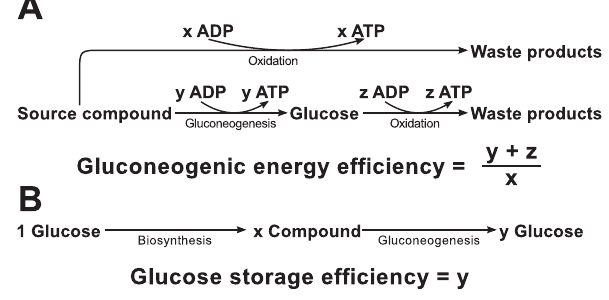
Figure 6. Pathway overview and storage efficiencies of selected compounds. A Overview of ATP, NADPH and NADH consumption for gluconeogenesis from acetyl-CoA for all detected pathways (see Text S1). Furthermore, Gibbs free energy changes of all pathways for gluconeogenesis from acetyl-CoA and palmitate are given. B Gluconeogenic energy efficiencies and glucose storage efficiencies for selected compounds. Amino acids marked with an asterisk cannot be synthesized from glucose in humans. ‘‘Palmitic acid (eff.)’’ refers to the most energy efficient pathway for gluconeogenesis from fatty acids (pathway 7) and ‘‘Palmitic acid (ineff.)’’ to the most inefficient pathway (pathway 20).